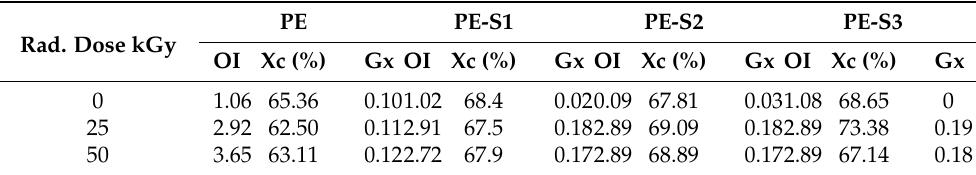
Table 4. Calculated important structural parameters from FTIR results. Rad. Dose